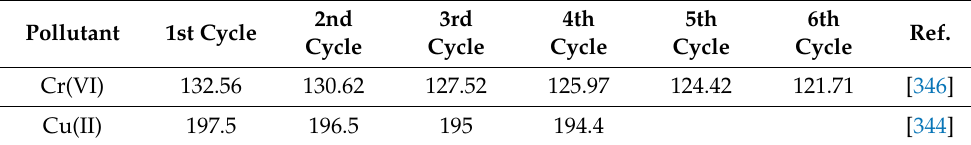
Table 7. Recycling adsorption capacity